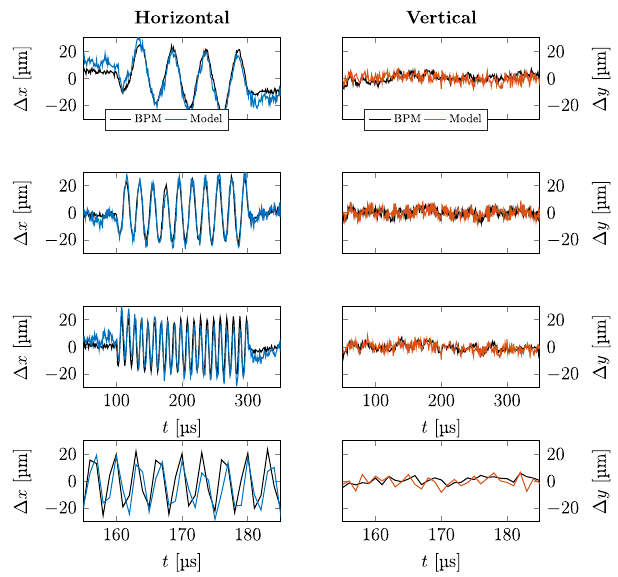
FIG. 15. Experimental observation of intrabunch train coupler kick variations at ACC6 at FLASH. Plotted are the differences between the reference trajectories and the particle trajectories while applying modulations with different frequencies on the forward power (from top to bottom: 20, 50, 100, and 300 kHz, cf. Fig. 14). The bunch spacing is 1 μ s. The BPM readout differences (black) and the corresponding model evaluations (colored) are plotted for the horizontal (left) and vertical (right) plane at the exit of the